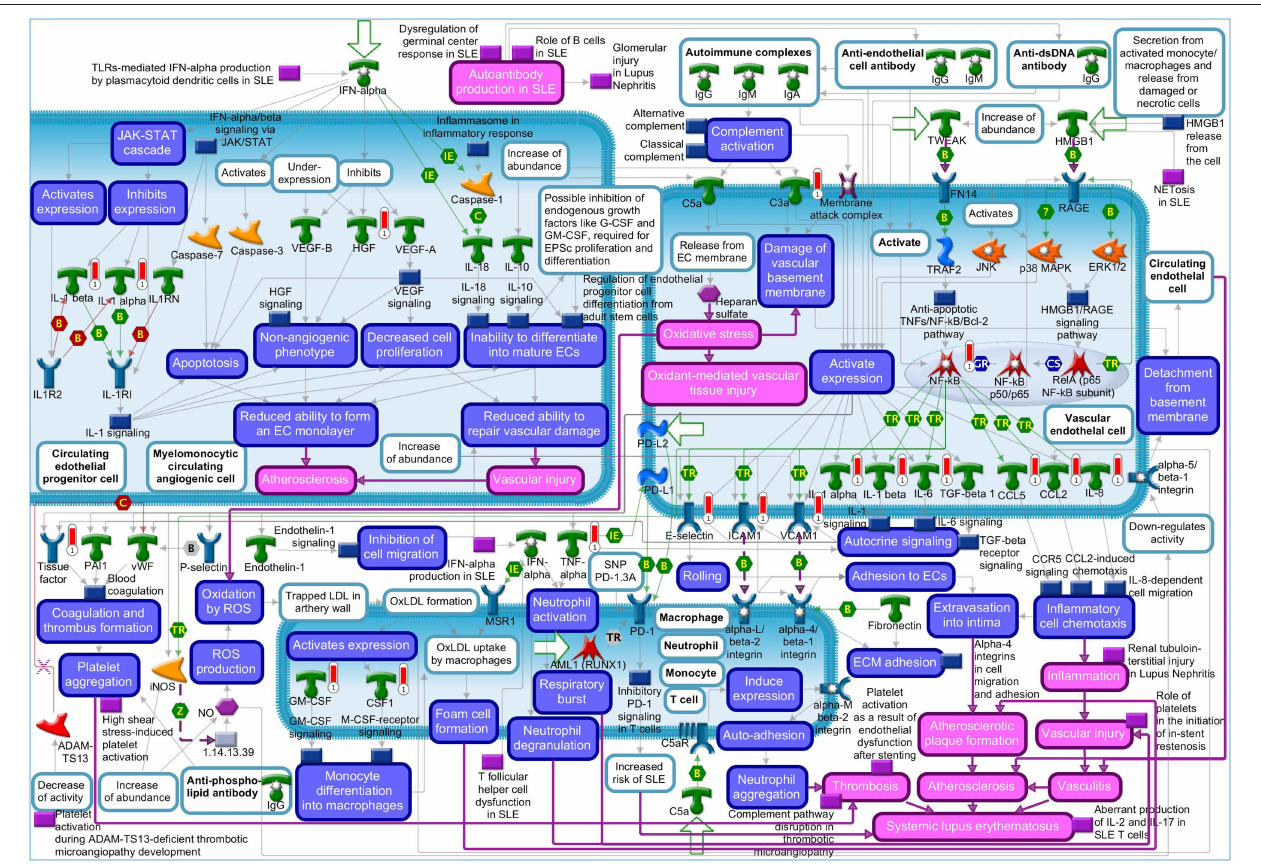
FIGURE 1 | Metacore TM map showing the signaling context of the genes contained in the “Vascular endothelial cell damage in SLE” pathway. Genes upregulated by 4h IL-1 β treatment are marked by red thermometer icons. Data are from three independent experiments.